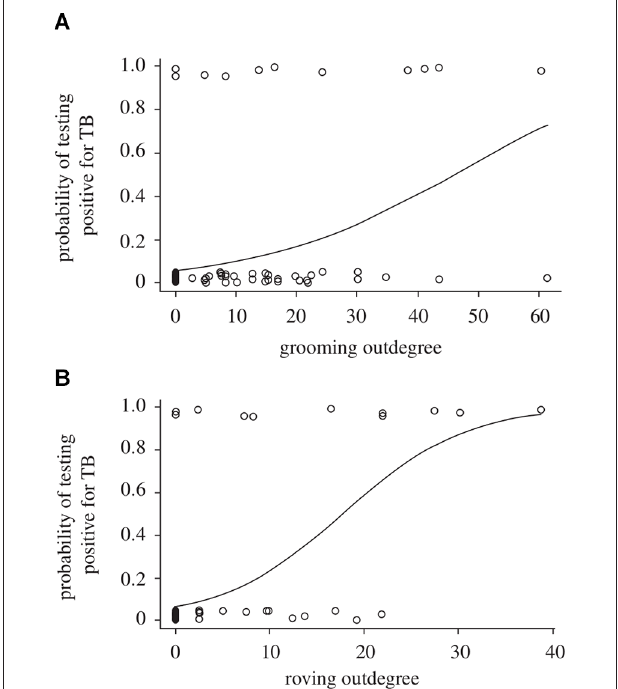
figURe 3 | Probability of individual meerkats testing positive for tuberculosis as a function of (a) the extent to which they groom others (grooming outdegree) and (B) the extent of intergroup excursions by males (roving male outdegree). [Adapted from ( 36 ), with the permission of The Royal Society ]. figURe 4 | (a) Survival rates (±95% CI) of blue tits infected with two strains